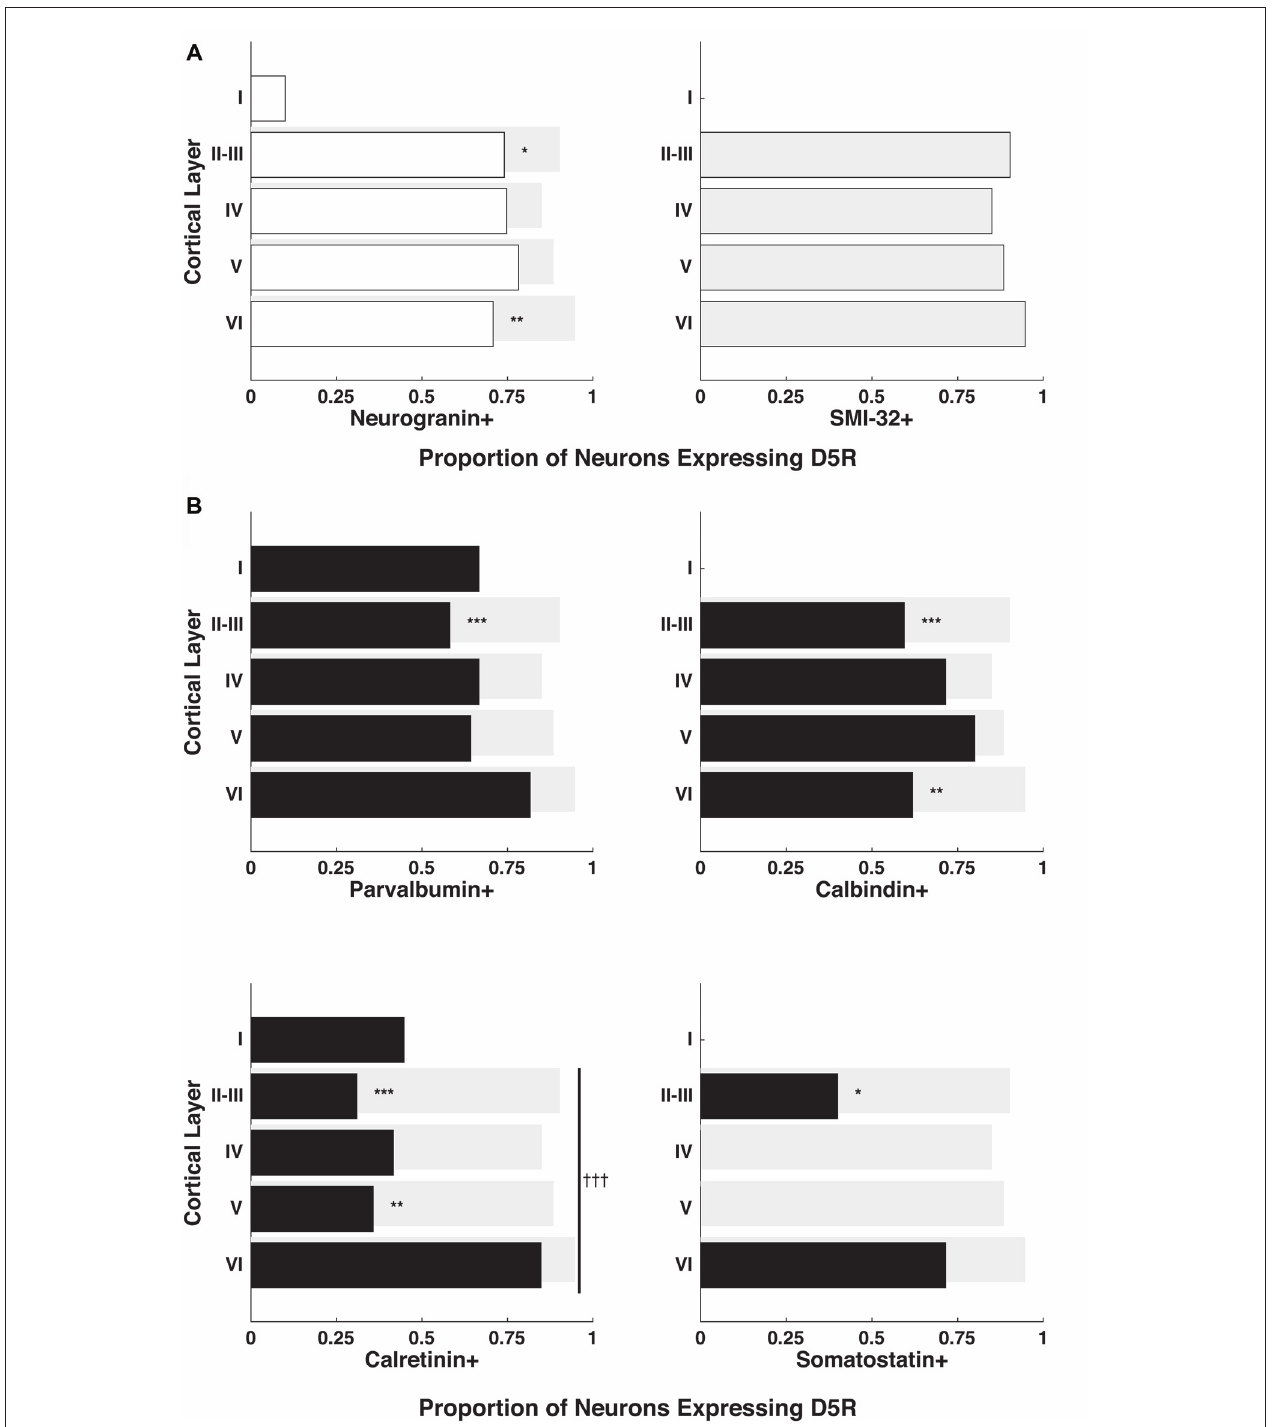
FIGURE 3 | Proportion of D5Rs on different cell types across cortical layers. (A) Neurogranin+ pyramidal neurons and SMI-32+ putative long-range projection neurons. (B) Parvalbumin+, calbindin+, calretinin+ and somatostatin+ inhibitory interneurons. Proportions are broken down by cortical layer (I, II–III, IV, V and VI) and compared to SMI-32+ D5R+ proportions (light gray bars). ∗ , ∗∗ and ∗∗∗ indicate significance at the levels of p ≤ 0.05, 0.01 and 0.001 (Bonferonni-adjusted values), respectively. Differences in the proportion of D5R+ neurons across layers were also calculated individually for each cell type. Only calretinin+ neurons exhibited a significant difference in D5R+ proportions across layers: indicated with a vertical line spanning layers II-VI and significance at the level of p ≤ 0.001 (Bonferonni-adjusted value) is indicated by ††† .